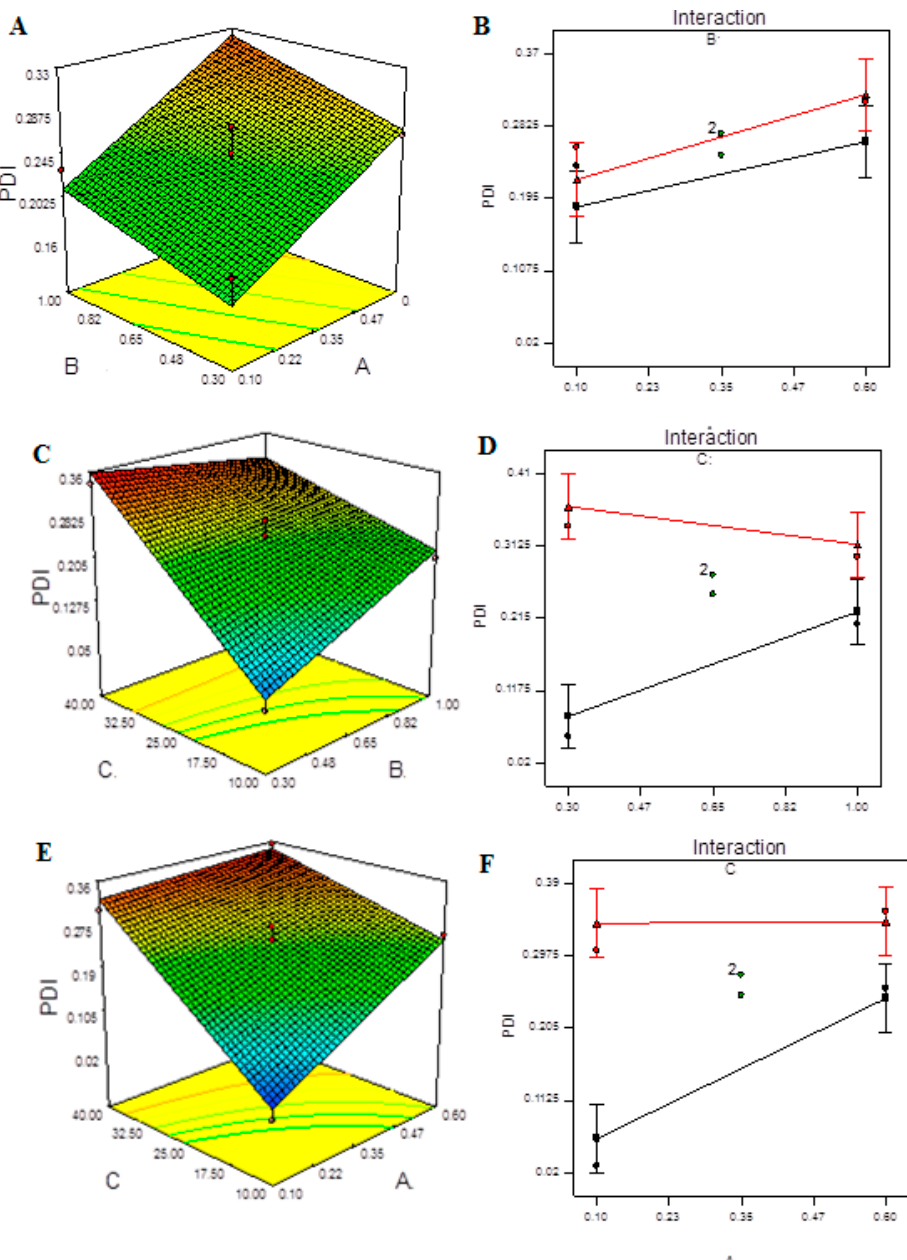
Figure 4. Model graphs: PDI. ( A ) Three-dimensional response surfaces plots showing the effect of variables (A: TPP concentration and B: CS concentration) on response (PDI), ( B ) inter- action plot, ( C ) 3D response surfaces plots showing the effect of variables (B: CS concentration and C: ultrasonication energy) on response (PDI), ( D ) interaction plot, ( E ) 3D response surfaces plots showing the effect of variables (A: TPP concentration and C: ultrasonication energy) on response (PDI) and ( F ) interaction plot. Table 9. ANOVA for response surface quadratic model.